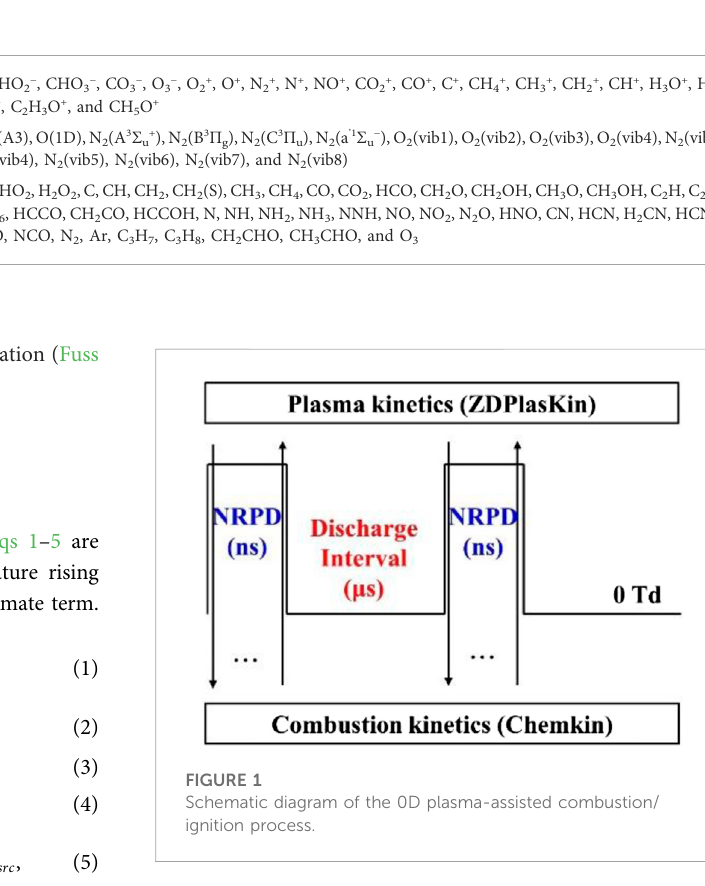
TABLE 2 Particles included in the detailed kinetic mechanism.